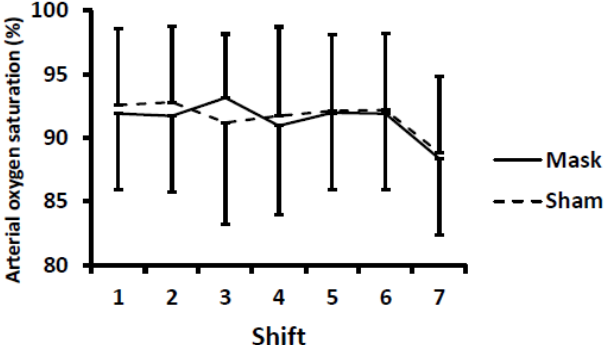
Figure 6. Heart rate during each simulated hockey shift. There were no differences between mask and sham conditions. There was a time main effect ( p < 0.01) with heart rate higher after the seventh shift (i.e., the repeated Wingate tests) compared to all other shifts. Values are means and error bars are SD.